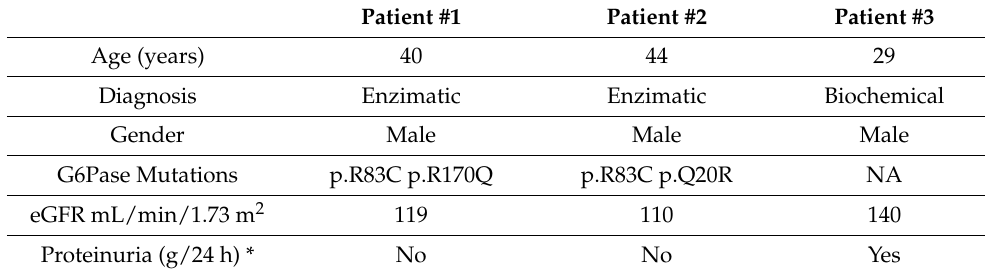
Table 1. GSD1a patient characteristics. * Proteinuria was defined as excretion of protein/24 h > 0.15 g [13]. Patient #1 Patient #2 Patient #3 Age (years) 40 44 29 Diagnosis Enzimatic Enzimatic Biochemical Gender Male Male Male G6Pase Mutations p.R83C p.R170Q p.R83C